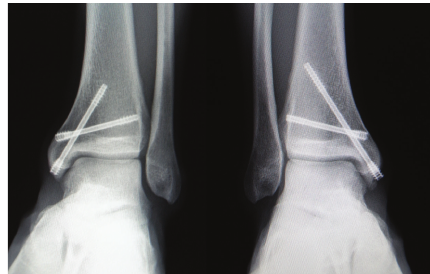
Figure 3: Anteroposterior radiograph at 4 years after surgery shows continued and complete bony healing in both